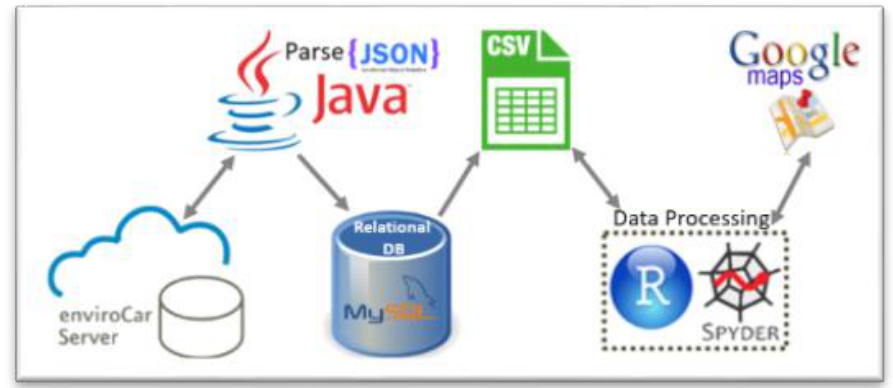
Figure 2. High-level scheme of the data preparation system architecture.